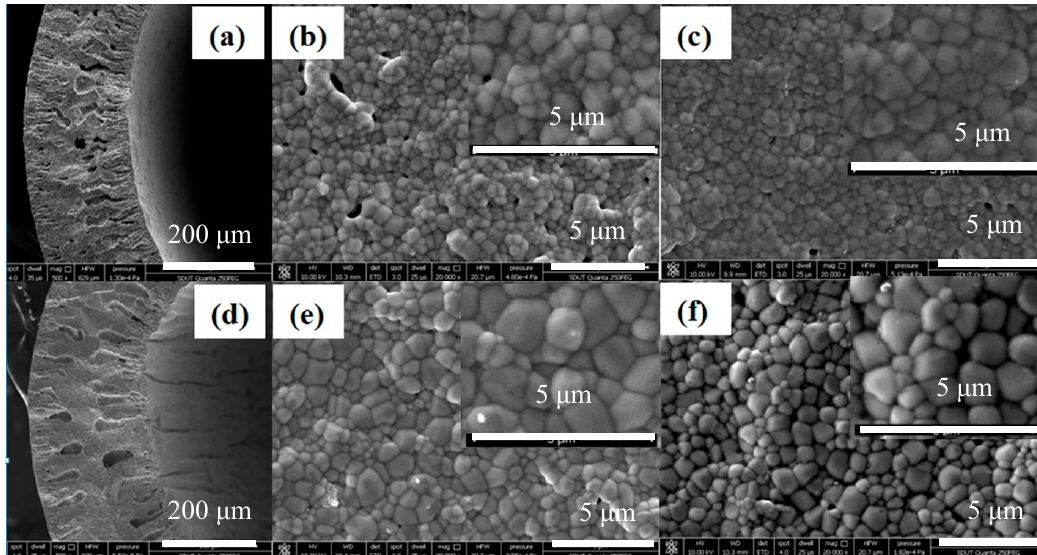
Figure 3. Typical SEM images of LCF and LCFA hollow fiber membranes ( a – c ) LCF; ( d – f ) LCFA; ( a , d ) cross section of fiber wall; ( b , e ) inner surface; ( c , f ) external surface (inset of ( b , c , e , f ) higher magnification; all magnification bar size at 5 microns).